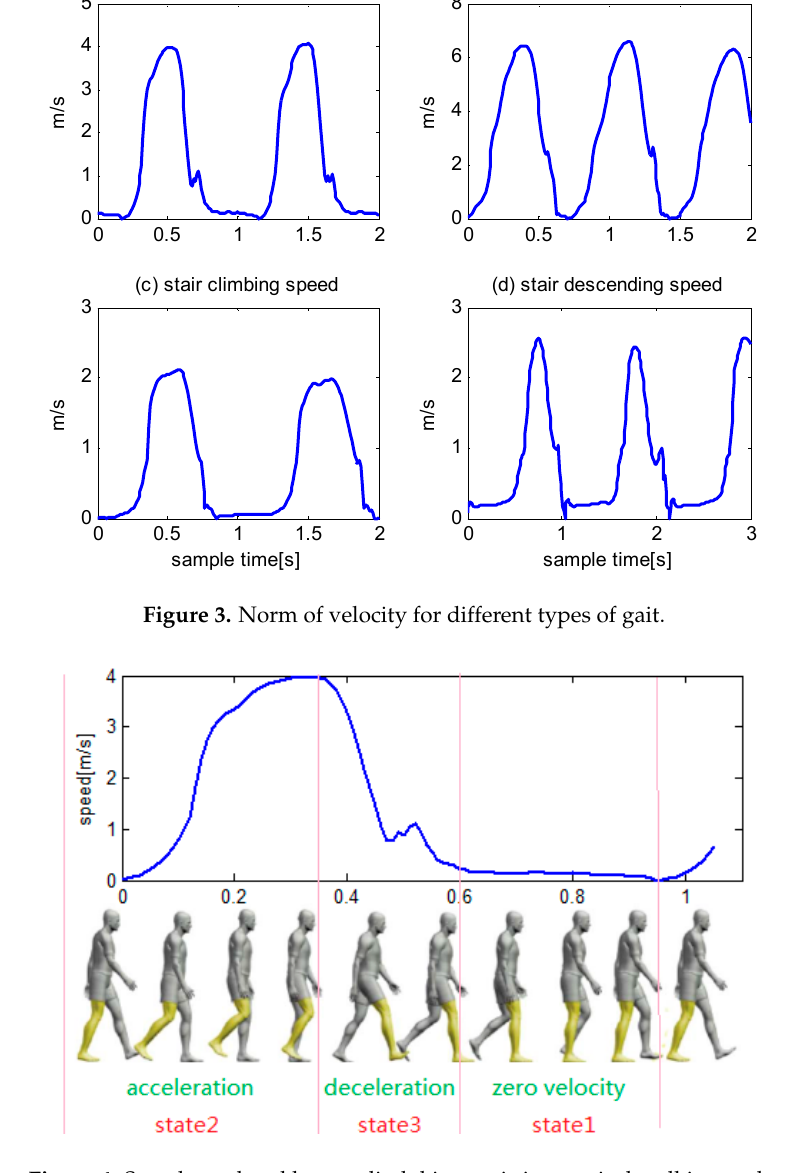
Figure 4 . Speed trend and human limb kinematic in a typical walking cycle.